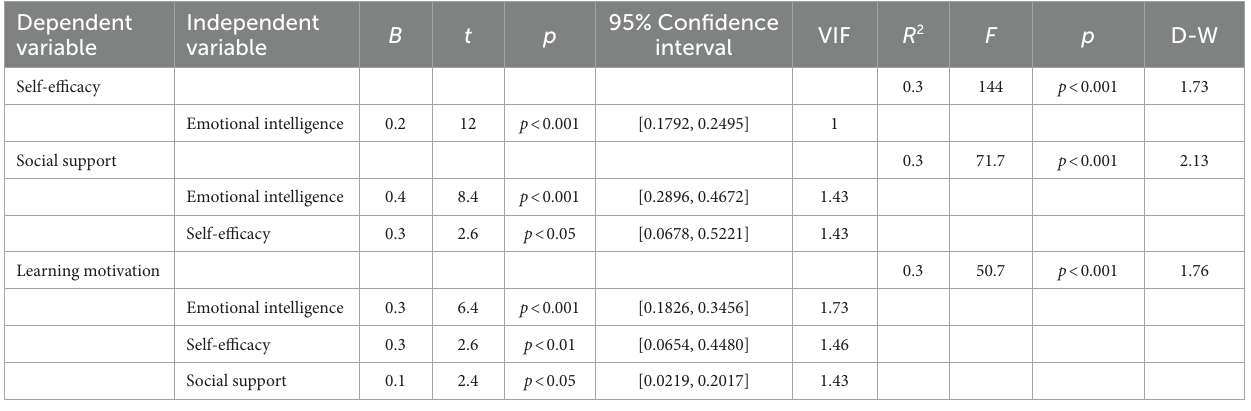
TABLE 7 Regression analysis results of the mediation model.